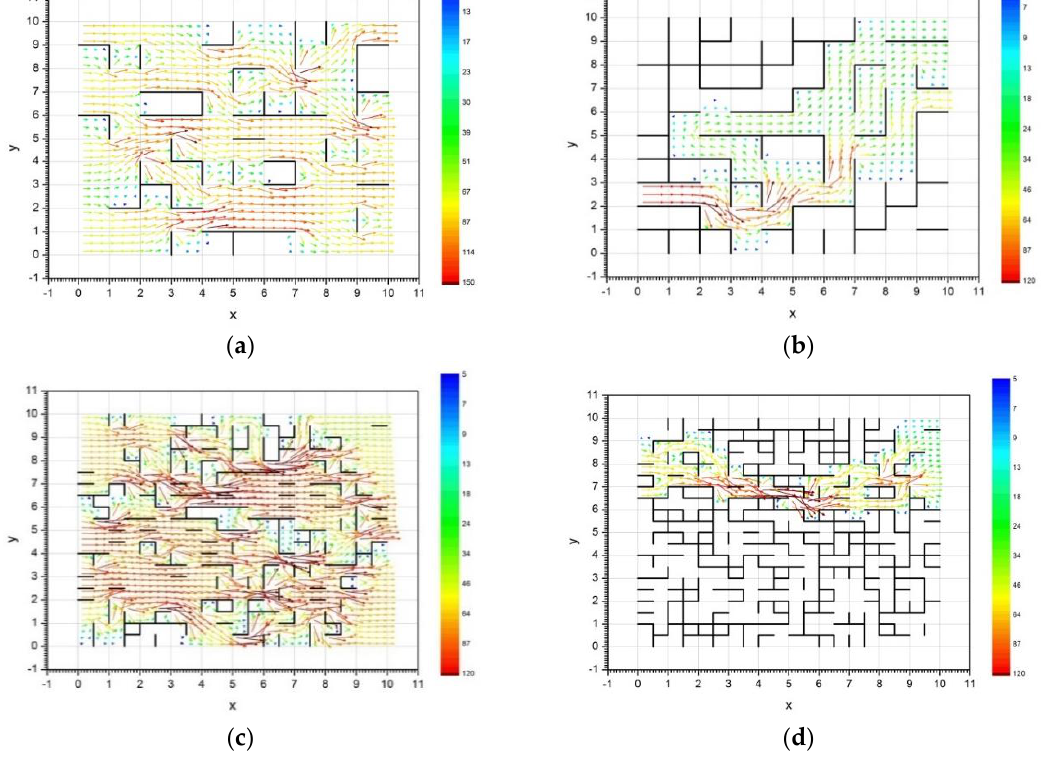
Figure 5. The examples of the obtained flow field distributions: ( a ) model 10 × 10, p = 26%, ( b ) model 10 × 10, p = 50%, ( c ) model 20 × 20, p = 26%, ( d ) model 20 × 20, p = 40%.